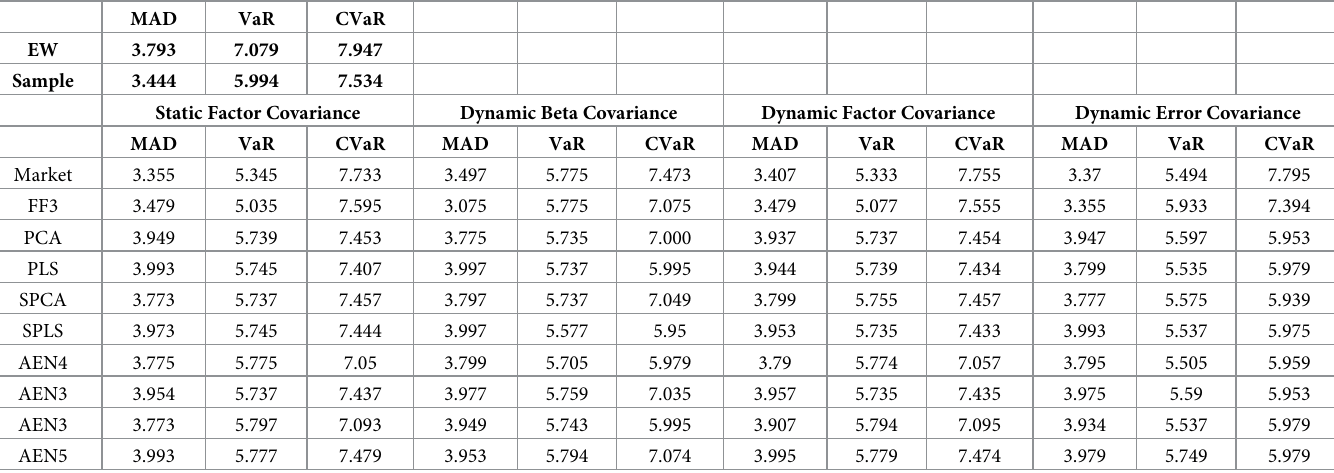
Table 5. Shows the results based on various risk indicators and the performance of a